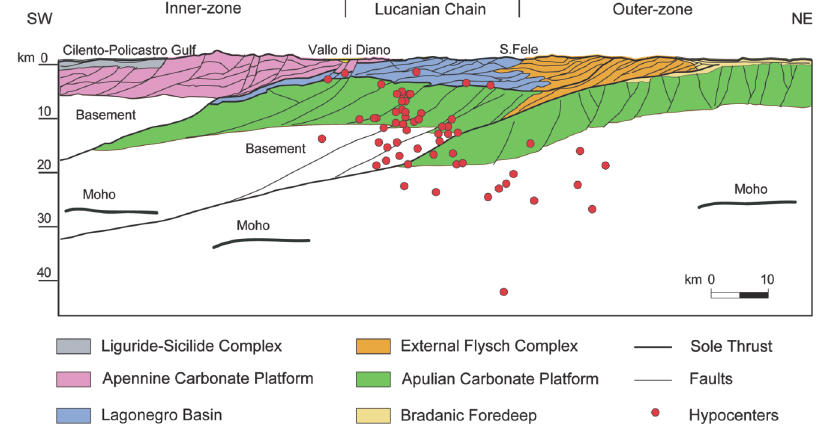
Fig. 9. Crustal and subcrustal seismicity (section AB in fig. 4) superimposed on the geological and structural interpretation of a NE-SW oriented seismic line (modified by Merlini and Cippitelli,